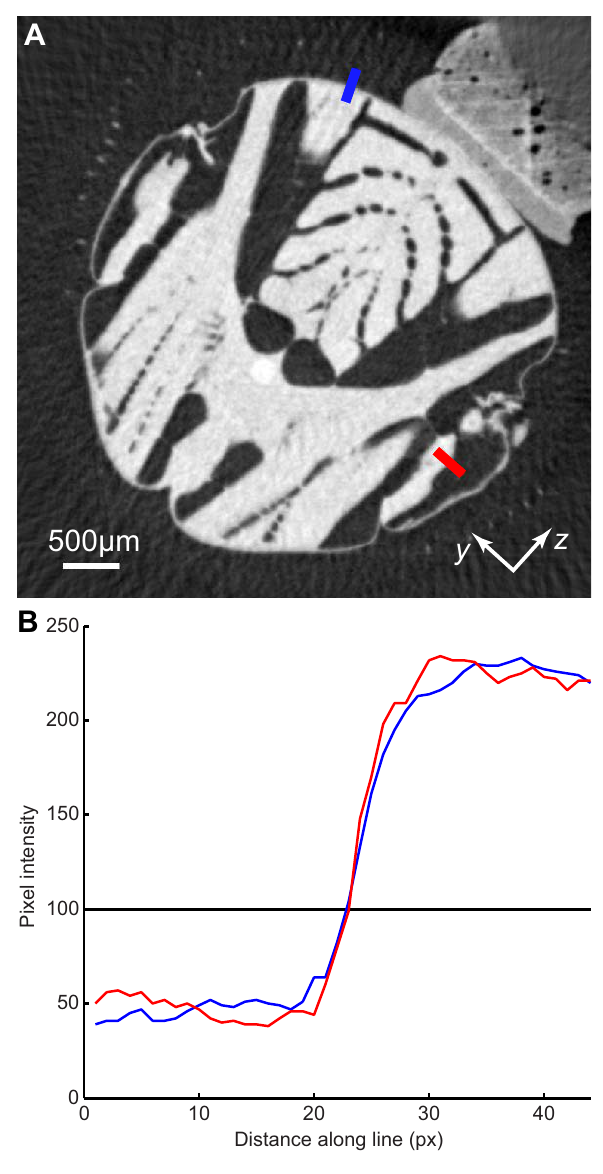
Figure 10. Edge detail of two parts of the thorax. (A) Tomogram showing transverse section of the thorax, with the mount visible in the upper right of the image. The blue line cuts through the scutum, which is a rigid part of the thorax that did not move measurably during recordings. The red line cuts through the steering muscles, which oscillate at wingbeat frequency. (B) Pixel intensities along the two lines indicated in (A). Edge sharpness, as measured by the steepness of the change in pixel intensity along each line, is essentially identical for the scutum and the steering muscles. This indicates that the position of the steering muscles must have been consistent between wingbeats, at the phase of the wingbeat shown here, which indicates that the steering muscle kinematics did not vary measurably between